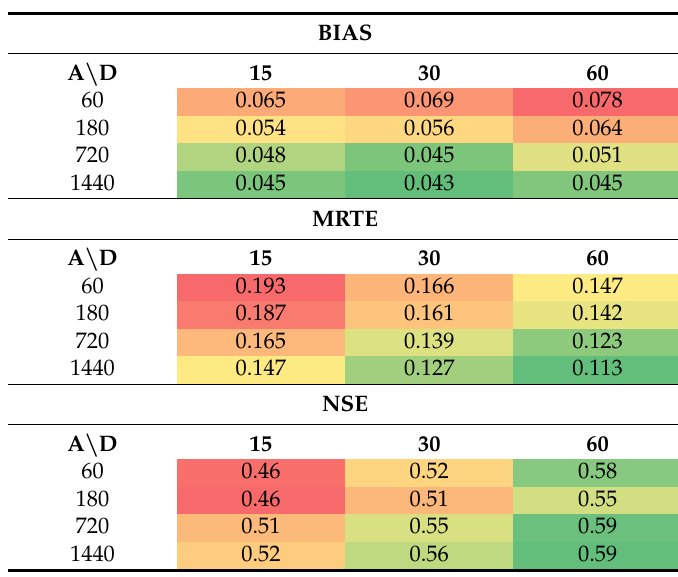
Table 6. The three indicators (bias, MRTE, and NSE) are reported for the 12 products of the UK case study, indicated with accumulation resolution (A) and downscaling resolution (D) in minutes. A conditional colour formatting is applied to easily compare the values, where green is a positive performance, and red a negative